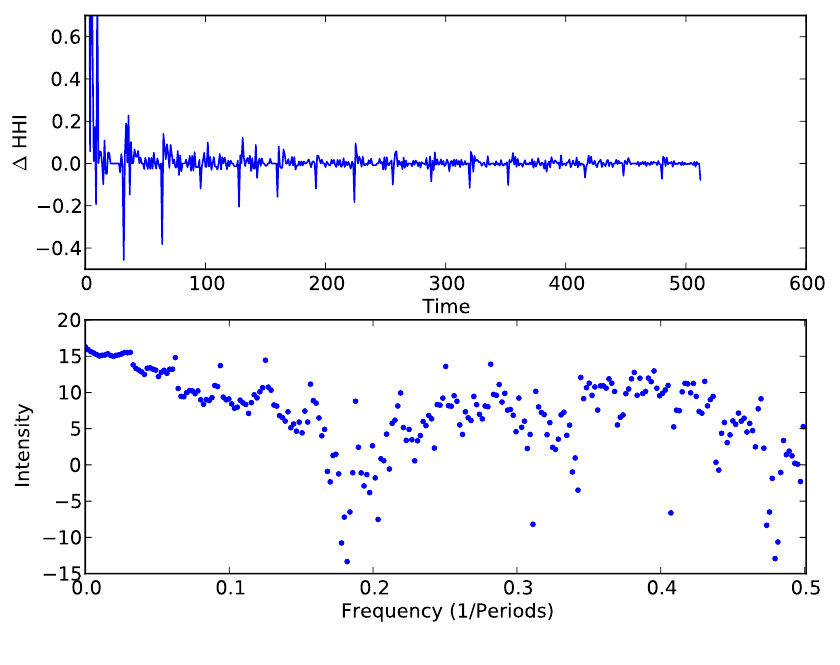
Figure 12. Development of the heterogeneity of the population (with respect to adherence to institutions) measured by the Herfindahl-Hirschman Index and the frequency spectrum of the Herfindahl Index time series for ↵ = 2 . 0 (see, also, figure